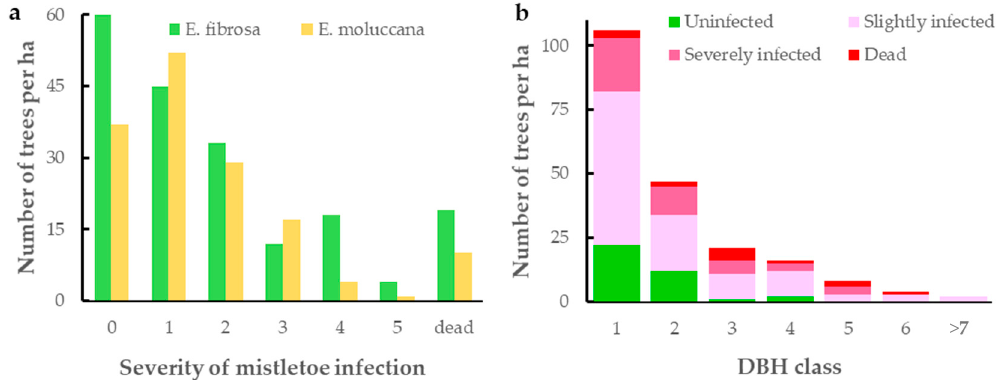
Figure 5. Distribution of the mistletoe infection. ( a ) Severity of the infection per species. ( b ) Distribution of uninfected, slightly infected (class 1 or 2), severely infected (classes 3–5) and dead trees per DBH class. DBH classes were defined as 10% classes according to the maximum observed DBH (83 cm).